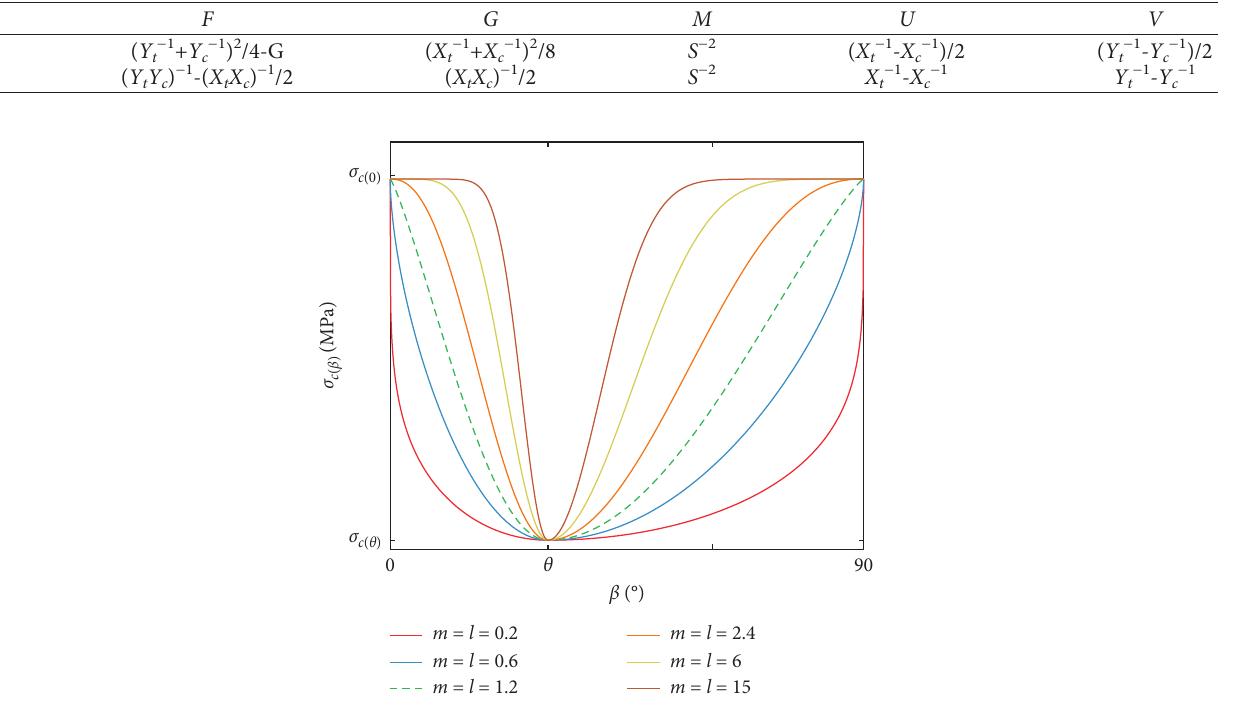
Figure 2: Predicted of Pariseau’s criterion vs. experimental